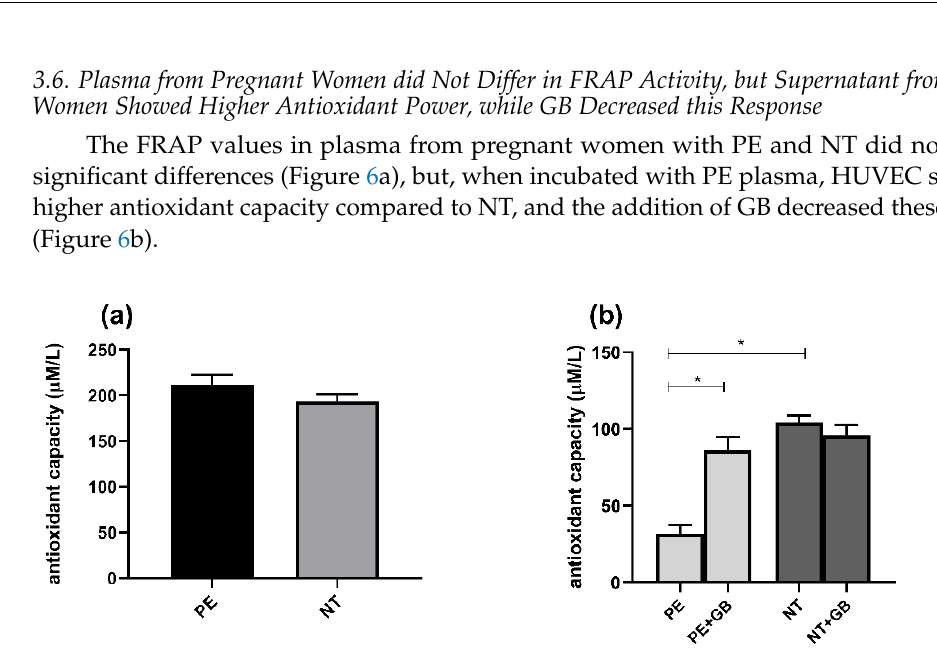
Figure 5. MDA was evaluated in the supernatant of human umbilical vein endothelial cells (HU- VECs) incubated with 20% ( v / v ) pooled plasma from PE (n = 10) and NT (n = 10) and GB (100 µM) for 24 h. Data are reported as means ± SEM. Comparisons between groups were assessed by One- Way ANOVA followed by Tukey’s Test. * ( p < 0.05).